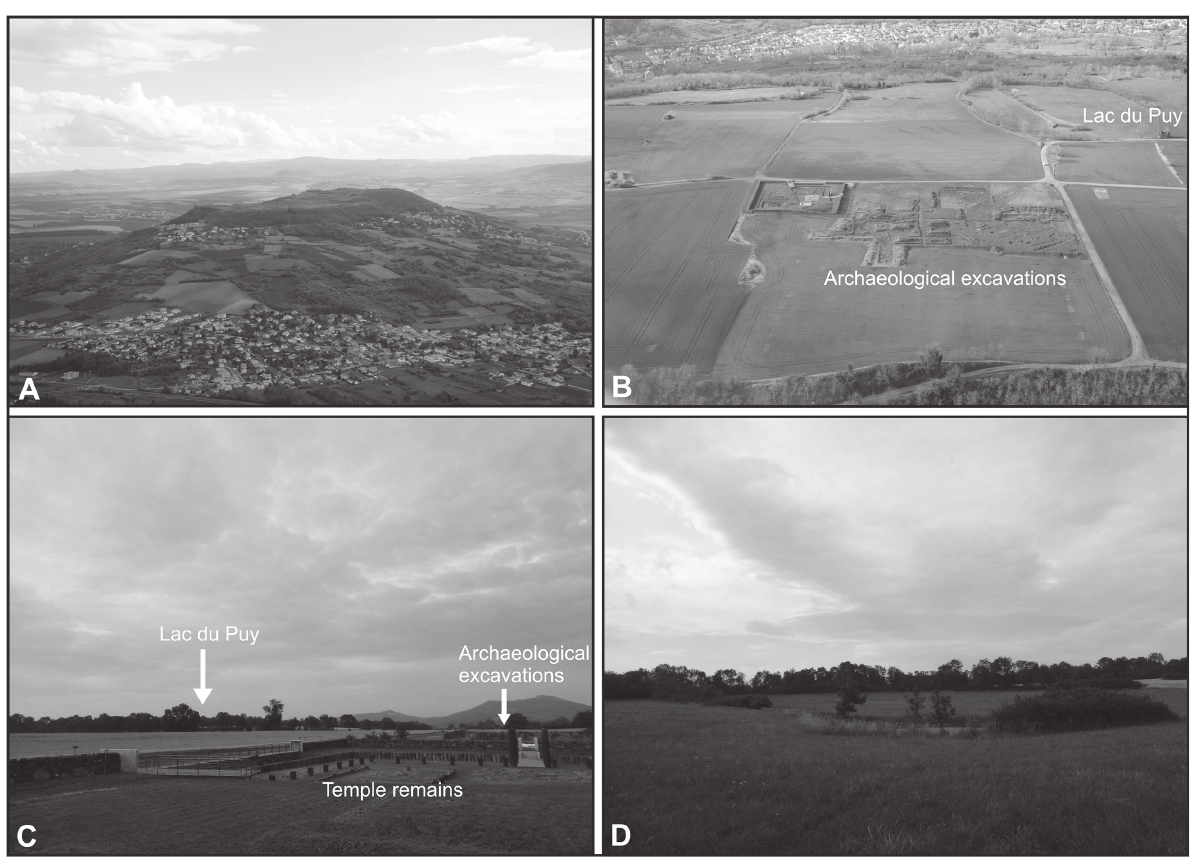
Fig 2. Photographs of the study site. [A] Corent plateau looking to the south (photo: B. Dousteyssier, 2014). [B] Aerial photograph looking northwest across the archaeological excavations and the Lac du Puy (photo: B. Dousteyssier, 2014). [C] View north across the plateau towards the Lac du Puy. Visible in the foreground are the excavated remains of a Gallo-Roman temple (photo: P.M. Ledger, July 2014). [D] View north across the Lac du Puy (photo: P.M. Ledger, July